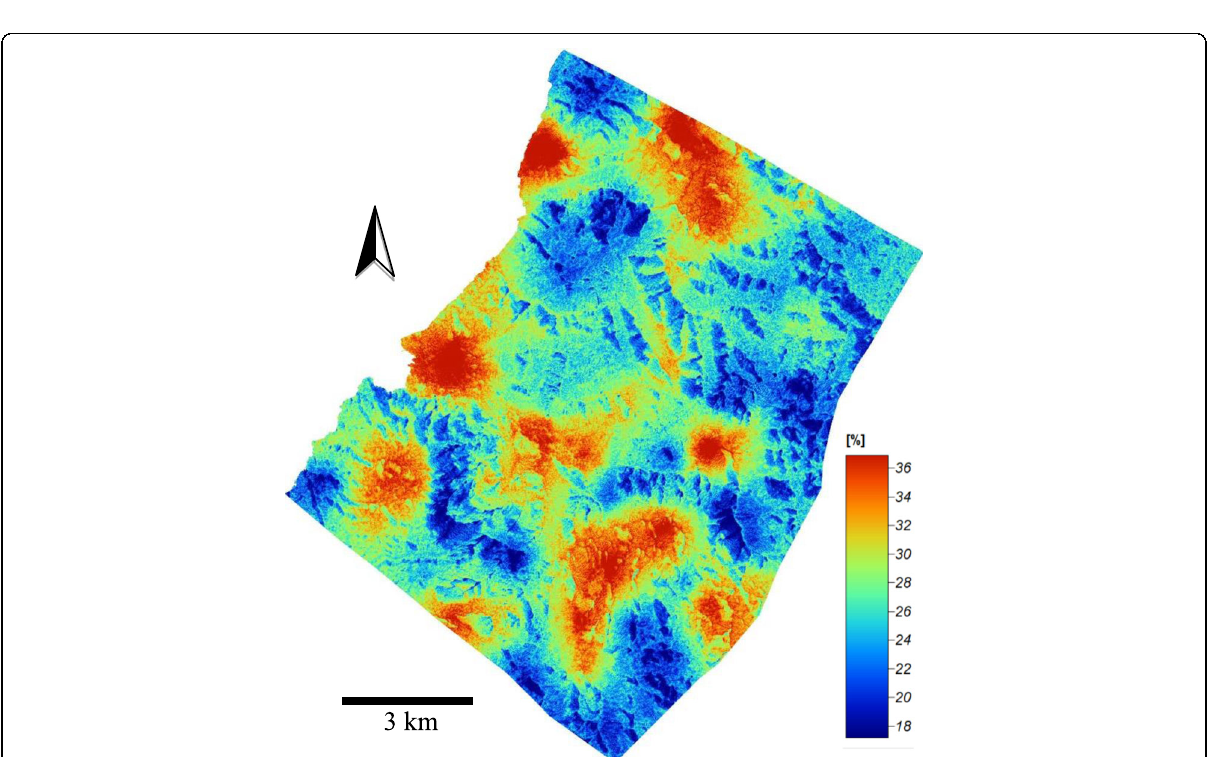
Fig. 12 Final model of Silt after back